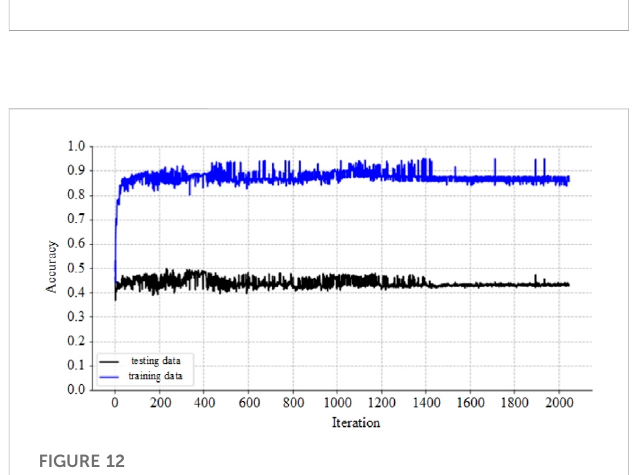
FIGURE 12 Accuracy of SAE